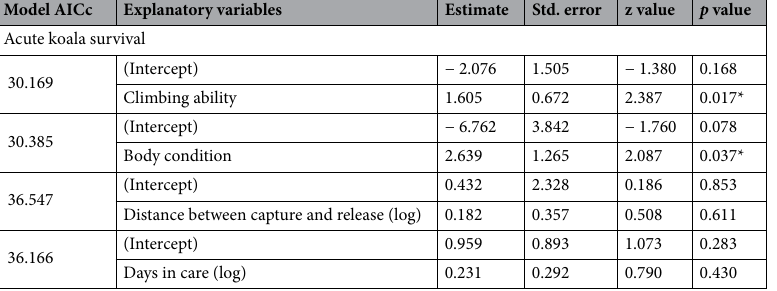
Table 3. Summary output for models examining climbing ability, body score, distance between capture and release sites, and days in care against acute survival. Significant relationships are identified by asterisks.